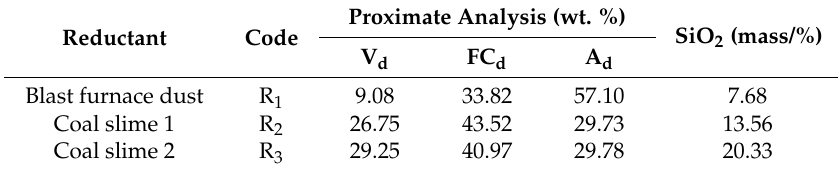
Table 2. The proximate analysis and SiO 2 content of different kinds of